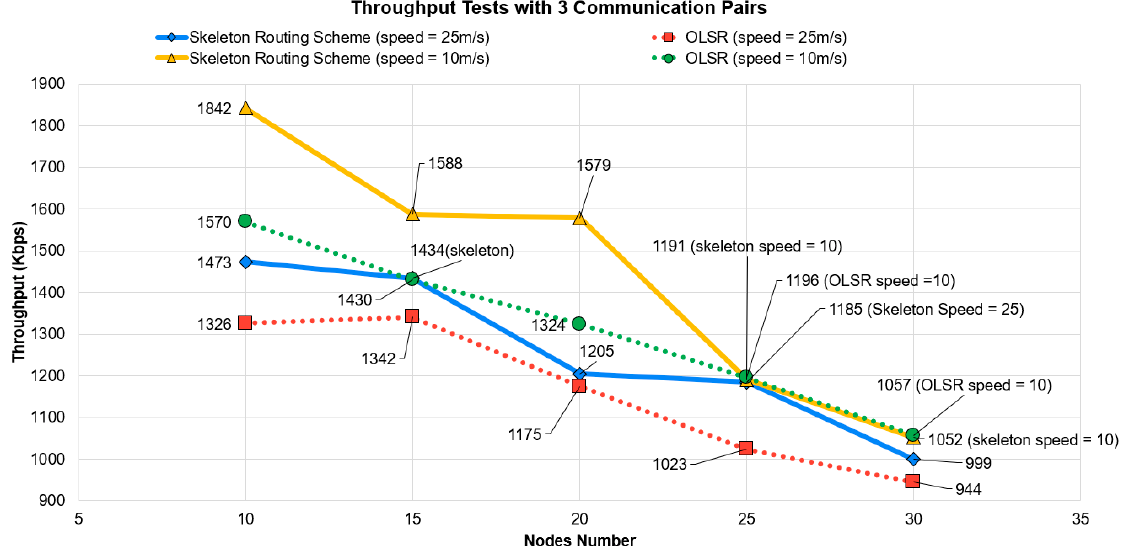
Figure 24. Throughput with different network sizes and node speeds.